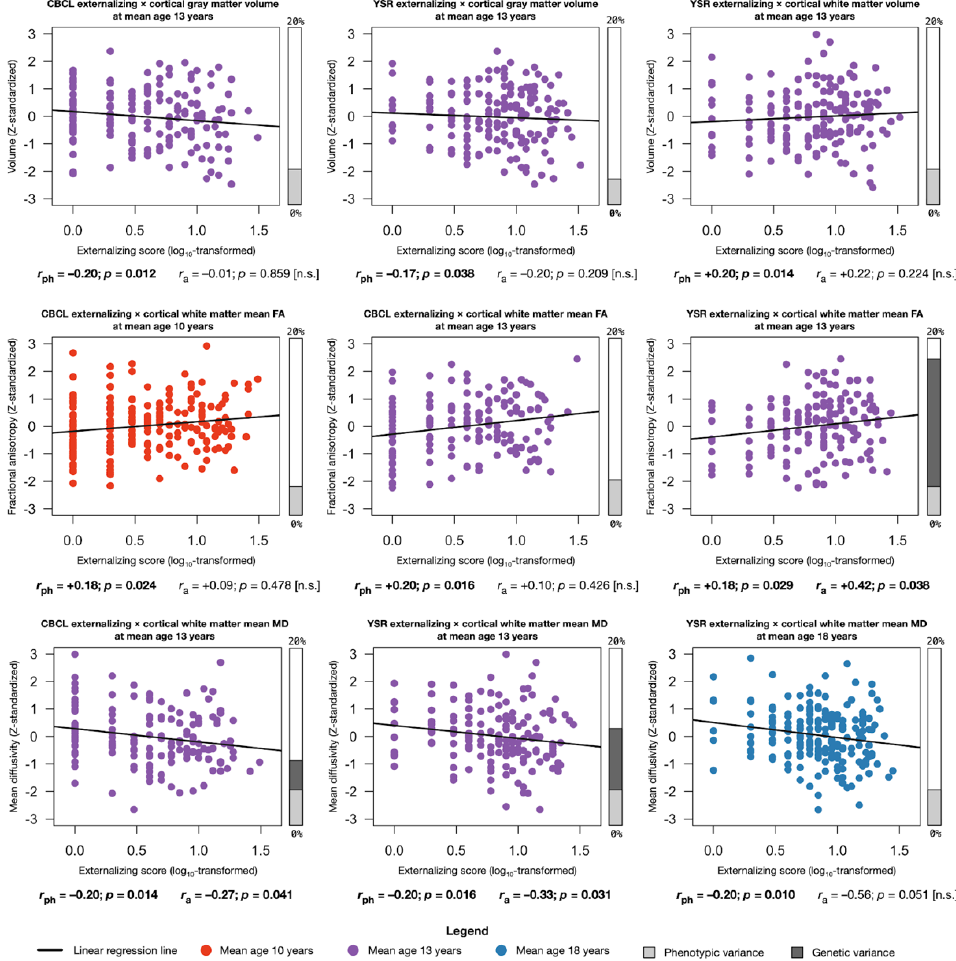
Figure 3. Associations between externalizing behavior and global brain structures throughout adolescence. Phenotypic association ( r ph ) of the log 10 -transformed scores of externalizing behavior on the CBCL or YSR questionnaire with Z-standardized measures of global brain structures (only listing uncorrected p < 0.05 significant associations). Bar charts display the total variance explained by the phenotypic (light gray) and genetic (dark gray) associations. Abbreviations (in alphabetical order): CBCL = Child Behavior Check List; FA = fractional anisotropy; MD = mean diffusivity; YSR = Youth Self Report.